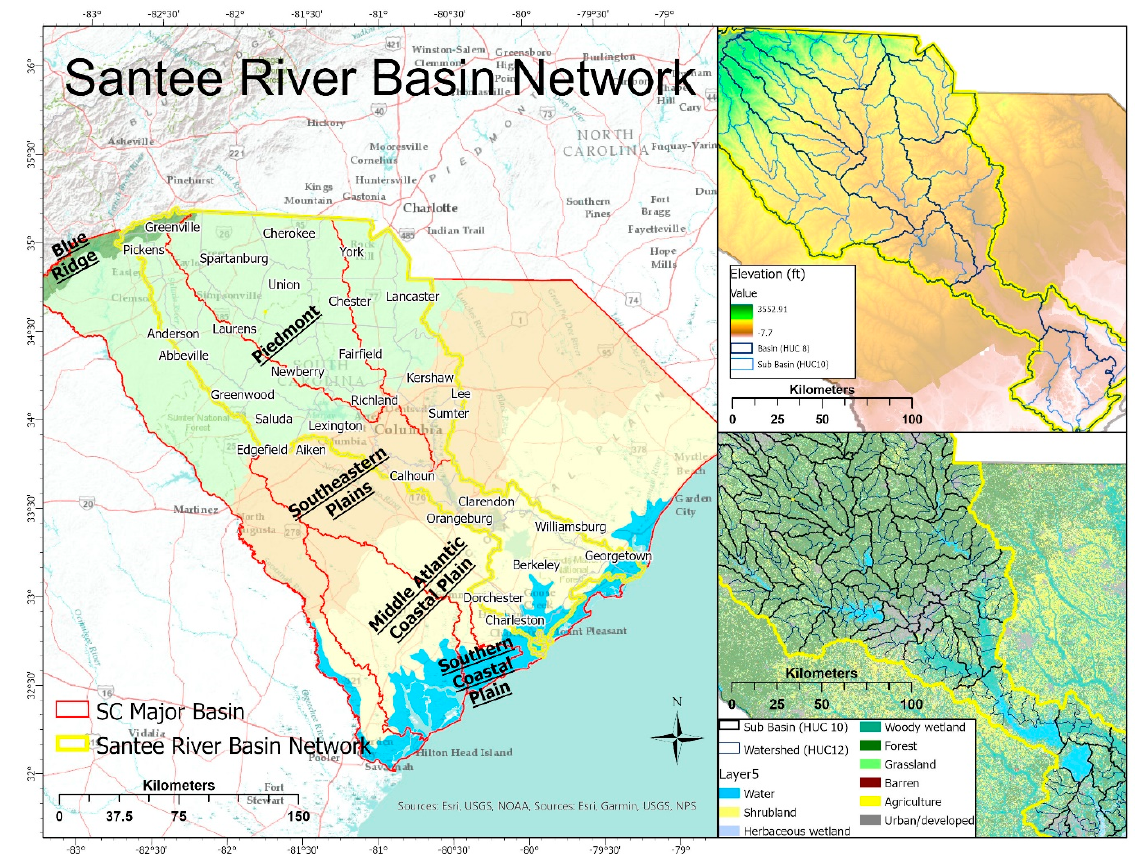
Figure 1. Santee River Basin Network (SRBN) Study Site.